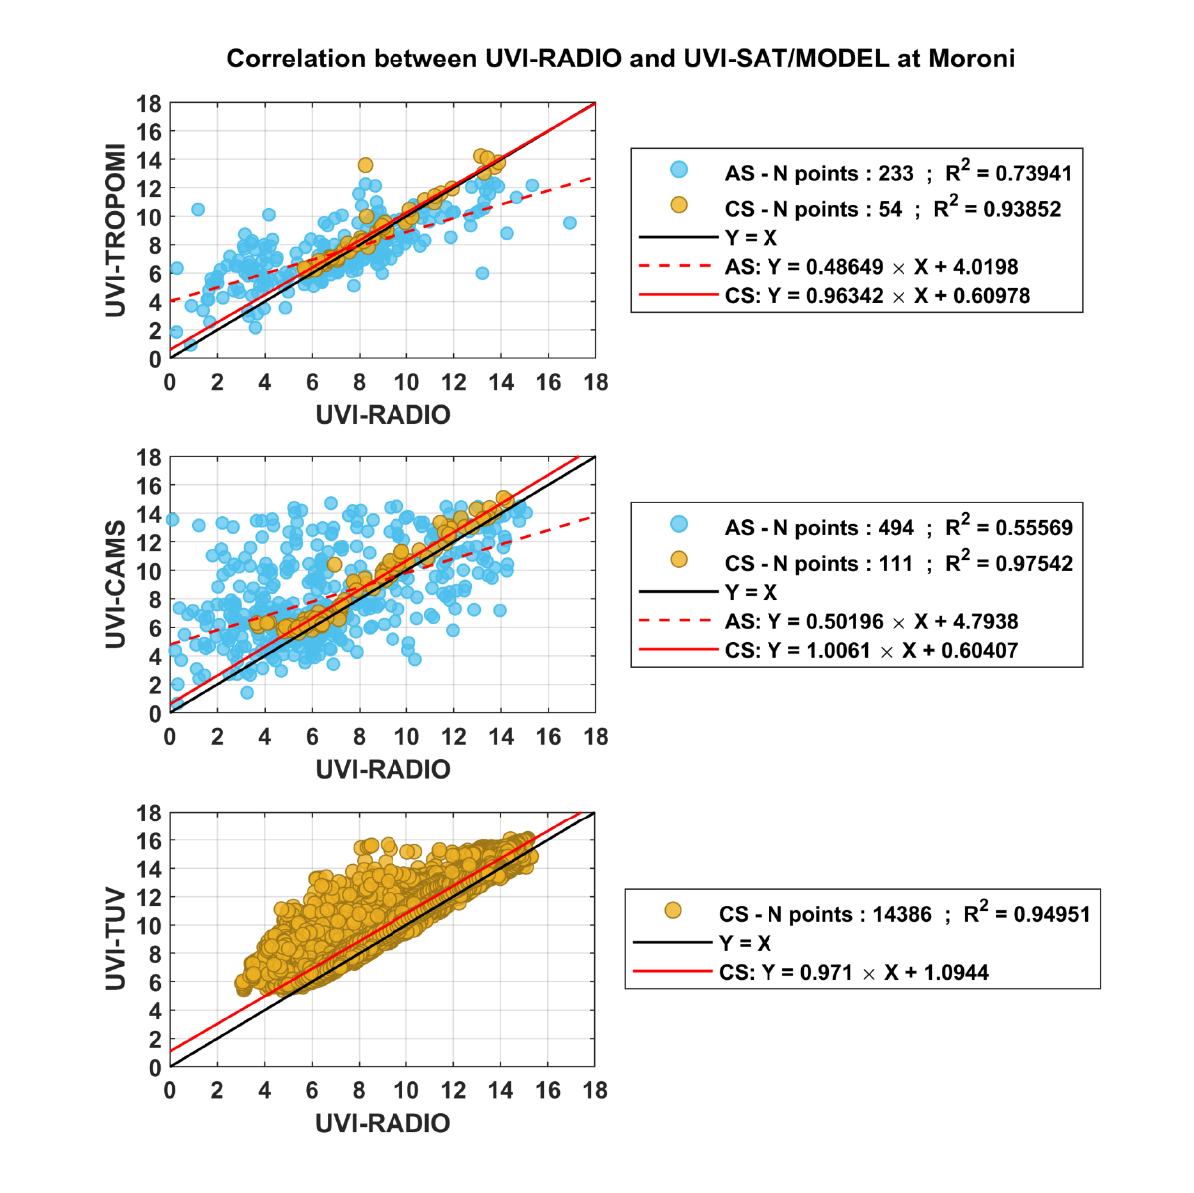
Figure 5. Correlation between UVI Satellite estimates or UVI Model results and UVI-Radio. All-Sky UVI are in blue circles. Linear fitting is represented by a red dashed line. Clear sky UVI are in yellow circles. Linear fitting is in solid red line. Table 2. Comparison results between UVI-TROPOMI or UVI-CAMS or UVI-TUV against UVI-RADIO in both all-sky and clear-sky conditions. RD stands for Relative Difference and AD for absolute difference. provided for these difference. R is correlation coefficient, and Ndata is number of data points